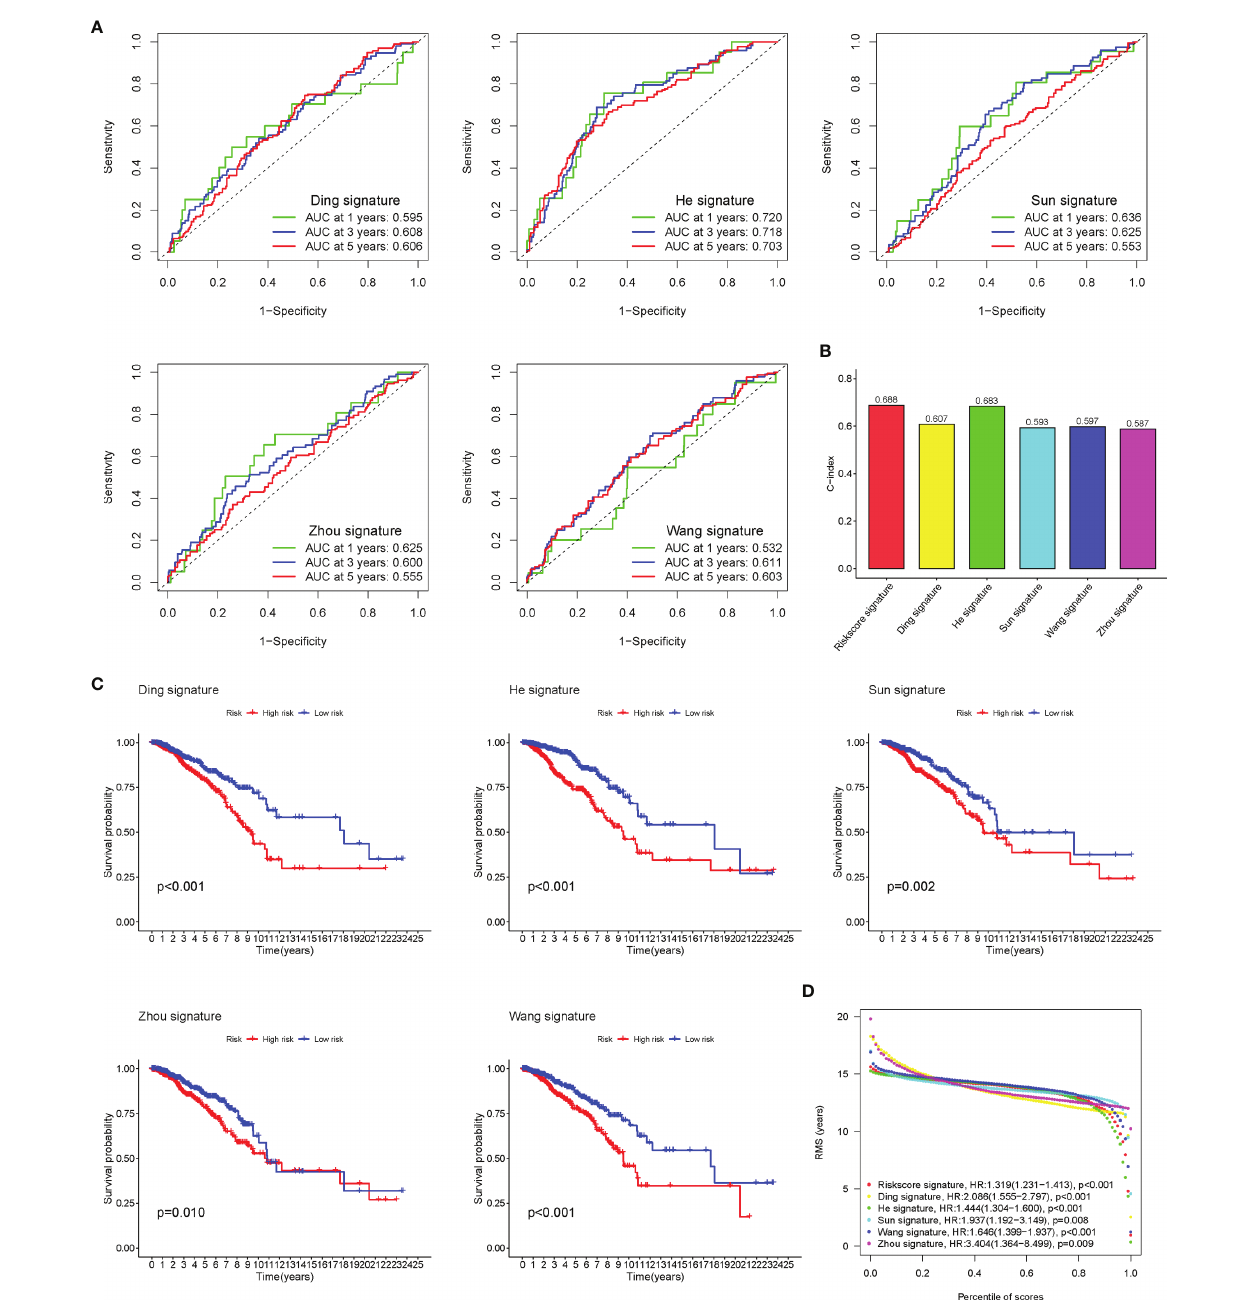
FIGURE 4 | Comparison of risk models. (A) The ROC curve of Ding, He, Sun, Wang, and Zhou signatures. (B) C-index comparison of six prognostic risk models. (C) The KM curve of low-risk and high-risk groups in the signature of Ding, He, Sun, Wang, and Zhou. (D) Restricted mean survival (RMS) curves for the six risk models. ROC, receiver operating characteristic; KM, Kaplan –